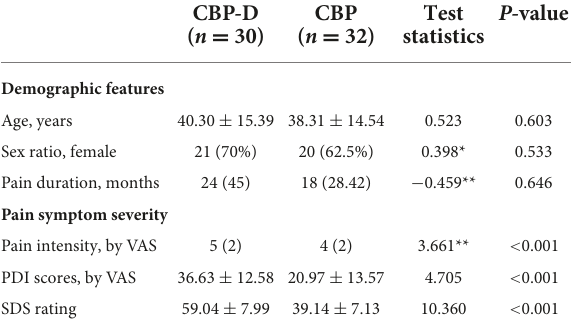
TABLE 1 Demographic and clinical characteristics and behavioral scores of the